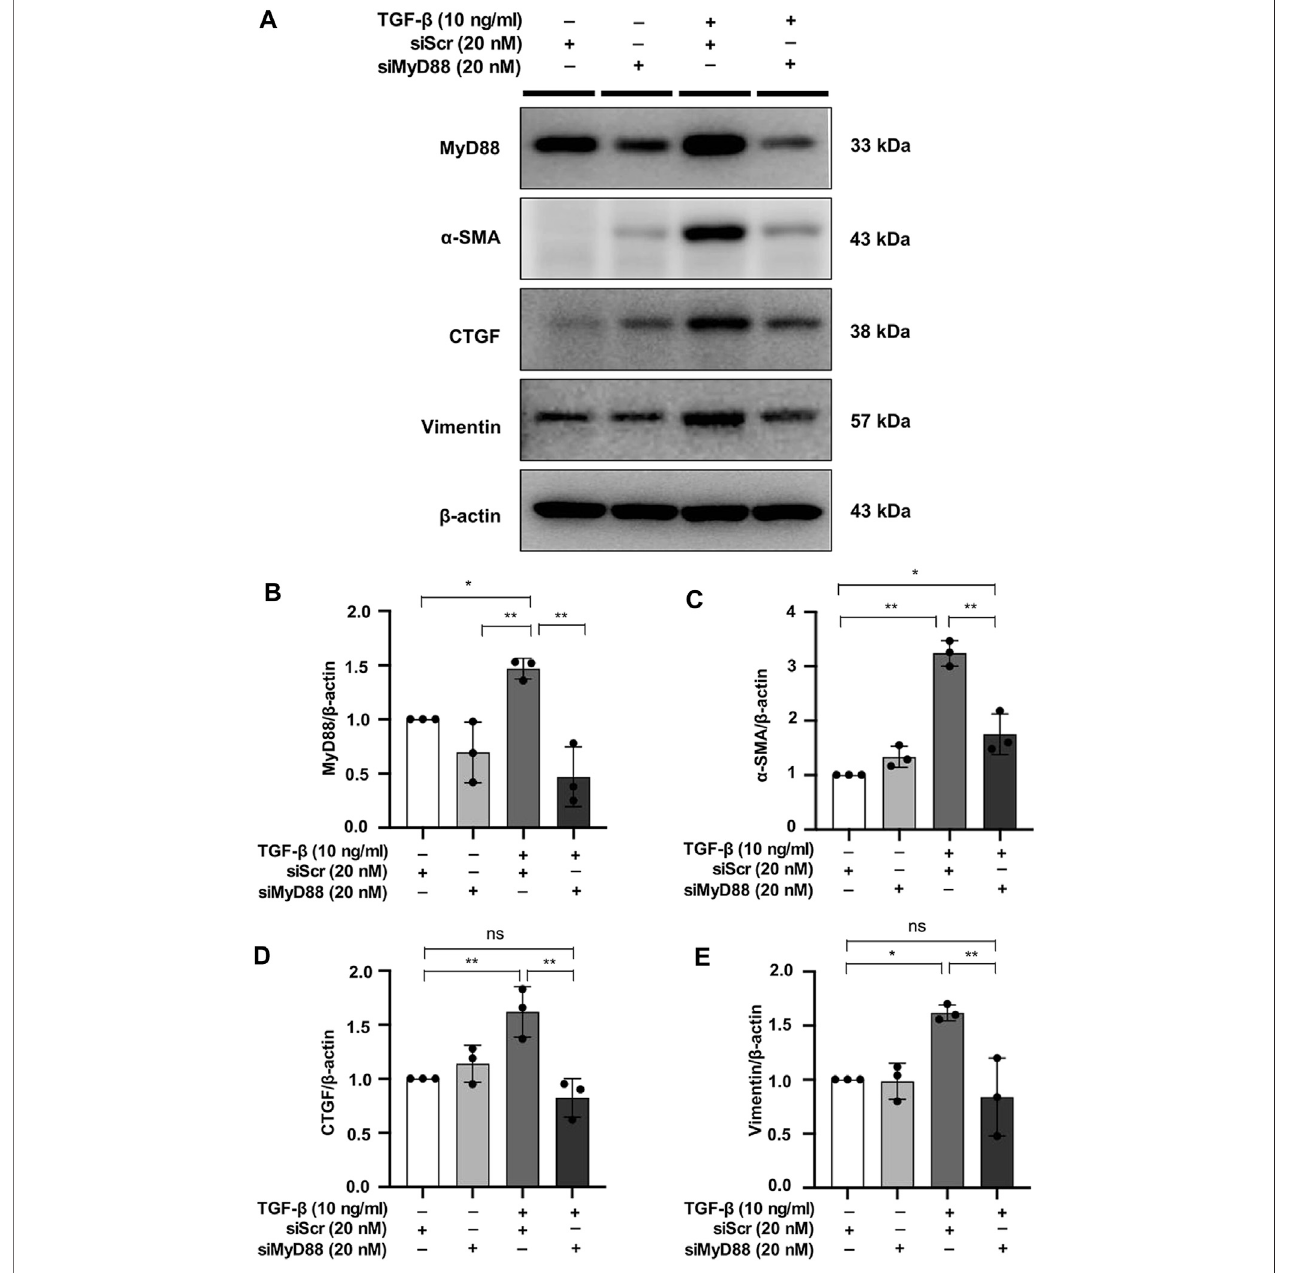
FIGURE6| MyD88silencinginhibits fi brosisinTGF- β -stimulatedNRK49Fcells. (A) WesternblottingdemonstratedthatMyD88silencingfacilitatedtheeffectonthe protein expression of α -SMA, CTGF, and vimentin in TGF- β -stimulated NRK49F cells. NRK49F cells were transfected with siMyD88 or siScr for 24 h in high-glucose DMEM without FBS, starved with 0.5% FBS medium, treated with TGF- β (10 ng/ml) for 30 min, and then incubated in 5% FBS medium for 24 h. Western blotting demonstratedthatMyD88expressionwassigni fi cantlyreducedbythespeci fi csiRNA.Resultswerenormalizedto β -actinexpression. (B – E) Statisticalsigni fi cance was presented as the mean ± SD, n (cid:1) 3. * p < 0.05, ** p < 0.01, ns: no signi fi cance. MA, maslinic acid; siRNA, small interfering RNA.